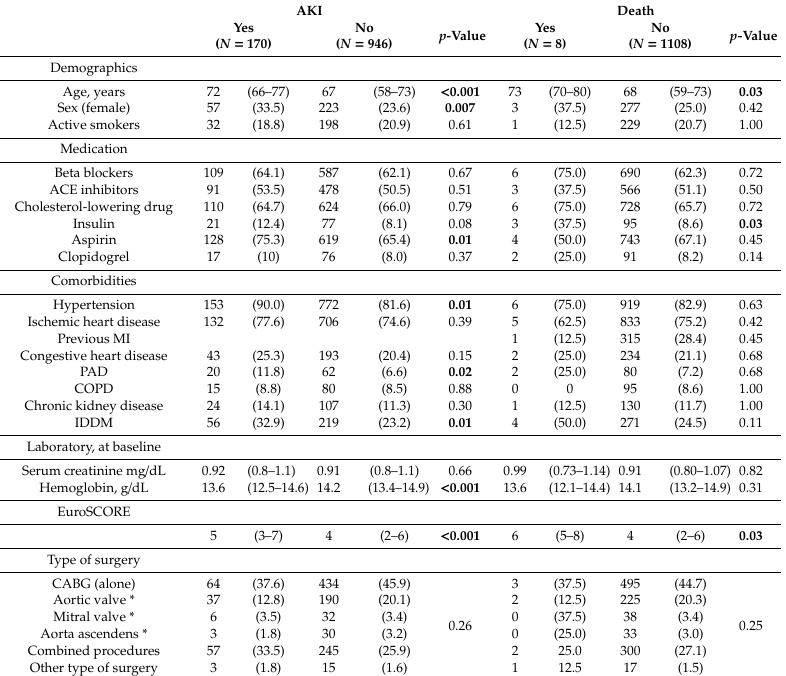
Table 1. Baseline and operative characteristics by AKI and